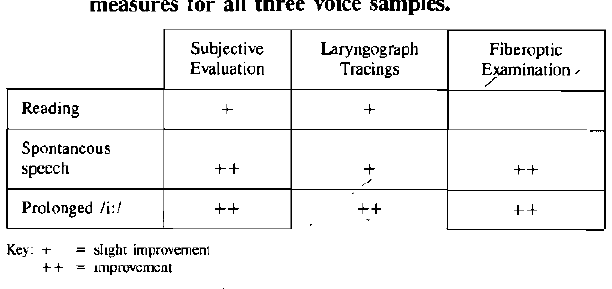
Table 5 Overall summary of pre- and post-therapeutic measures for all three voice samples.